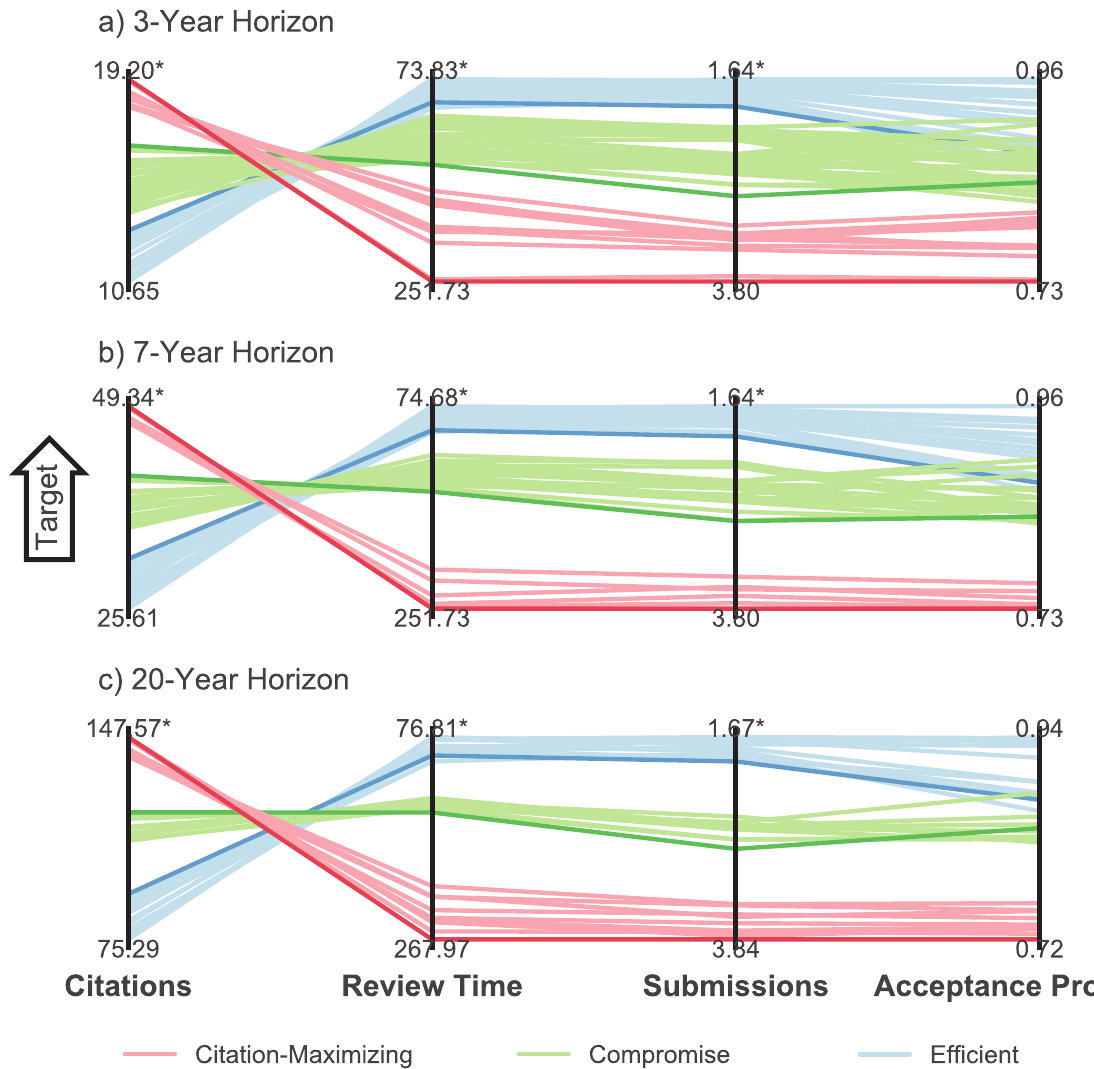
Fig 4. Visualizing multi-objective trade-offs. Parallelaxis plots for the (a) junior researcher( T = 3 years), (b) tenure-seeking researcher ( T = 7 years) and (c) tenured researcher ( T = 20 years). Each vertical axis represents one of the three objectives,with the best simulated values at the top. Each horizontally-oriented shadedregionrepresentsa different journalsubmissionstrategy and boundsthe range of Pareto-approximatesolutionsfor that strategy. Red follows Citation-MaximizingStrategies, blue follows Efficient Strategies (moderate citations and fast publication)and green follows Compromise Strategies. The bold solutionsdenote the maximum-citation sequencewithin each strategy.